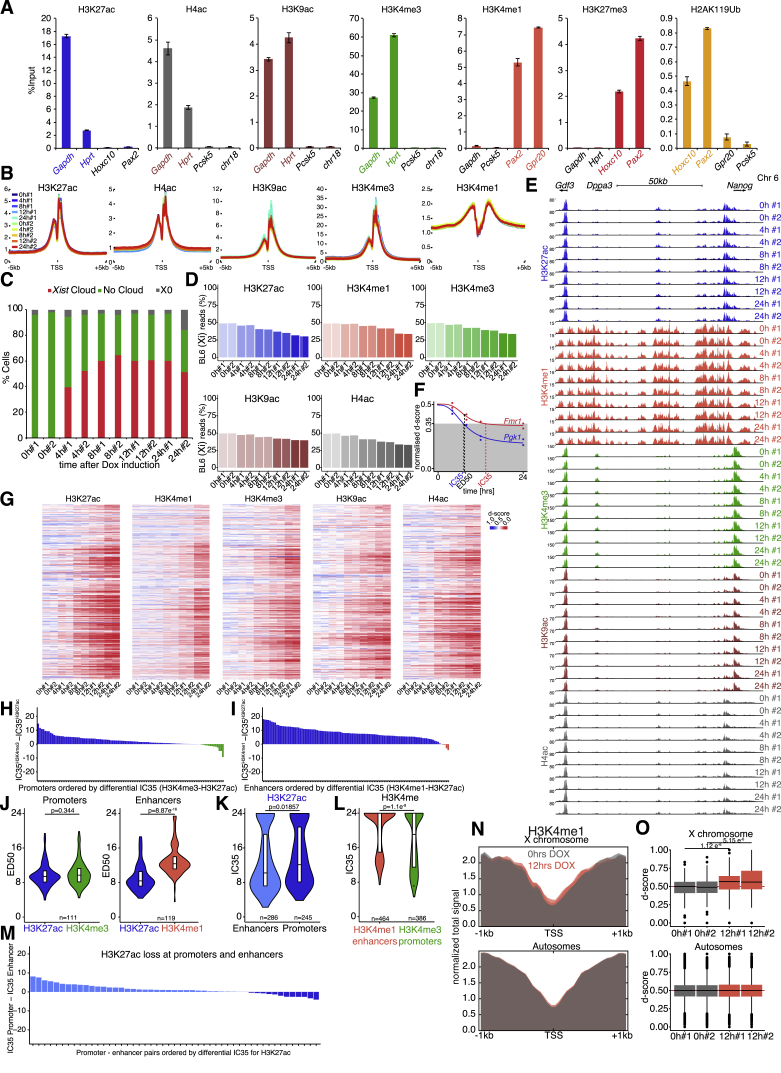
Allele-Specific Native ChIP-Seq Monitors Changes in Active Histone Modifications during XCI, Related to Figure 1(A) nChIP enrichment validation using qPCR. Shown is the enrichment of nChIP signal at positive (color) and negative (black) control regions for each mark individually. Shown is a representative result for one biological replicate. Values were normalized to the input sample. (B) Average enrichment plots for active histone modifications across all transcriptional start sites. (C) RNA FISH quantification of Xist induction (p510 probe) during both replicates of nChIP-seq time course. At least 70 nuclei were quantified for each sample. (D) Bar plots showing the percentage of B6(Xi) reads mapping to the X chromosome in the nChIP-seq time course. (E) Genome browser plots of active histone modification at the Gda3/Dppa3/Nanog cluster. Shown are all mapped reads at all time points in biological duplicates. Note highly reproducible and stable pattern of enrichment. (F) Example showcasing the differences between IC35 and ED50 parameters. The IC35 measures when the loss of a histone mark reaches an efficiency threshold and not the timing when this process occurs most rapidly. For example, if two marks show different efficiency of loss from the Xi (i.e., different IC35) the process might still be occurring at the same time. Shown is H3K27 deacetylation dynamics for two promoters (Fmr1:red, Pgk1:blue). Both promoters have the same ED50 (i.e., time when sigmoid reaches its maximum slope), however show very different efficiency of deacetylation. The latter difference is captured by the IC35 parameter (i.e., time when sigmoid reaches the 0.35 threshold). (G) Heatmaps showing the d-scores of all peaks on the X chromosome. Windows were sorted from centromere (top) to telomere (bottom). (H-I) Plots showing the distribution of differential IC35 (H): H3K4me3-H3K27ac; (I): H3K4me1-H3K27ac) for all promoters (H) and putative enhancers (I). Each bar represents a single window, these were ordered accordingly to their differential IC35. (J) Violin plots comparing the dynamics of H3K27ac and H3K4 methylation loss at active promoters (left) and putative active enhancers (right). Plots compare the ED50 parameter of H3K27ac and H3K4me peaks within the quantitative range of the experiment (IC35 < 24hrs). p value was calculated using paired Wilcoxon rank sum test.(K-L) Violin plots comparing the distribution of IC35 for H3K27ac (K) or H3K4me1/3 (L) at enhancers and promoters. p values calculated using Wilcoxon rank sum test. (M) Plots showing the distribution of differential IC35 for H3K27ac at promoter-putative enhancer pairs. Windows within one TAD were paired based on proximity. Individual pairs were ordered accordingly to their differential IC35. (N) Average H3K4me1 distribution plots around the transcriptional start site of active genes (TSS ± 1kb). Plots were done using all mapped reads on TSS of active genes on X chromosome (top) and on autosomes (bottom). Average profiles show duplicates at 0hr (gray) and 12hrs (orange) of DOX treatment. (O) Boxplots showing the d-score distribution for H3K4me1 around TSS of active genes (±200bp) after 0 (gray) and 12hrs (orange) of DOX treatment, on X chromosome (top) and on autosomes (bottom). p values calculated using Wilcoxon rank sum test.